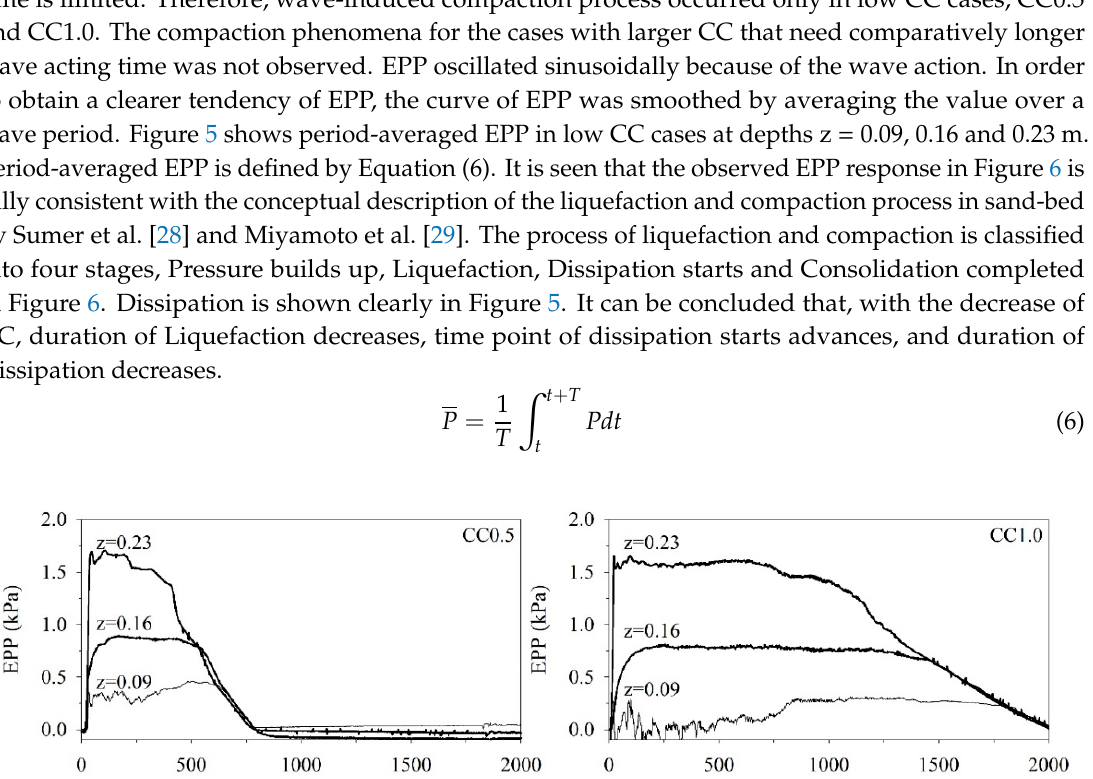
Figure 6. Schematic variation of period-averaged pore-water pressure at depth z. Figure 7 shows screenshots of experiment video of CC0.5. Screenshots are taken every 20 s. Here are representative pictures. It can be seen that a thin suspended sand layer is above the bed surface and there is no obvious deformation of bed at 20 s, while EPP reached maximum at z = 0.09 m around 25 s. The seabed began to fluctuate and suspended sand layer became thick at 40 s. The trough of the seabed corresponds to the wave crest and vice versa. EPP reached maximum at z = 0.23 m around 50 s as shown in Figure 5. Sediment suspension on the bed surface was divided into two layers: thick layer (red line) and thin layer (yellow line) at 60 s. The shape of sediment suspension changed from mushroom cloud to strip from 80 s to 800 s. EPP dissipated around 405 s at z = 0.23 m, 545 s at z = 0.16 m and 635 s at z = 0.09 m as shown in Figure 5. EPP Dissipation finished at around 800 s. It is difficult to see the change of seabed fluctuation on the screenshot. From the video, it can be seen that the fluctuation amplitude of seabed decreases gradually at 440 s and stops at 580 s. Sand ripples begin to form in 700 s. Sediment suspension dissipated when EPP dissipation completed.